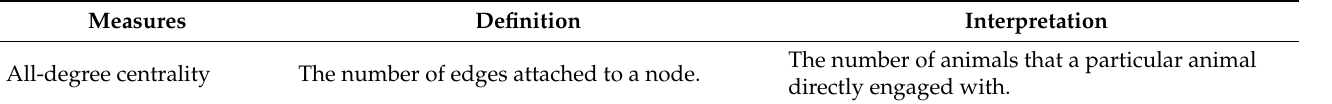
Table 1. The definition of the social network analysis traits considered in this study. Measures Definition Interpretation All-degree centrality The number of edges attached to a